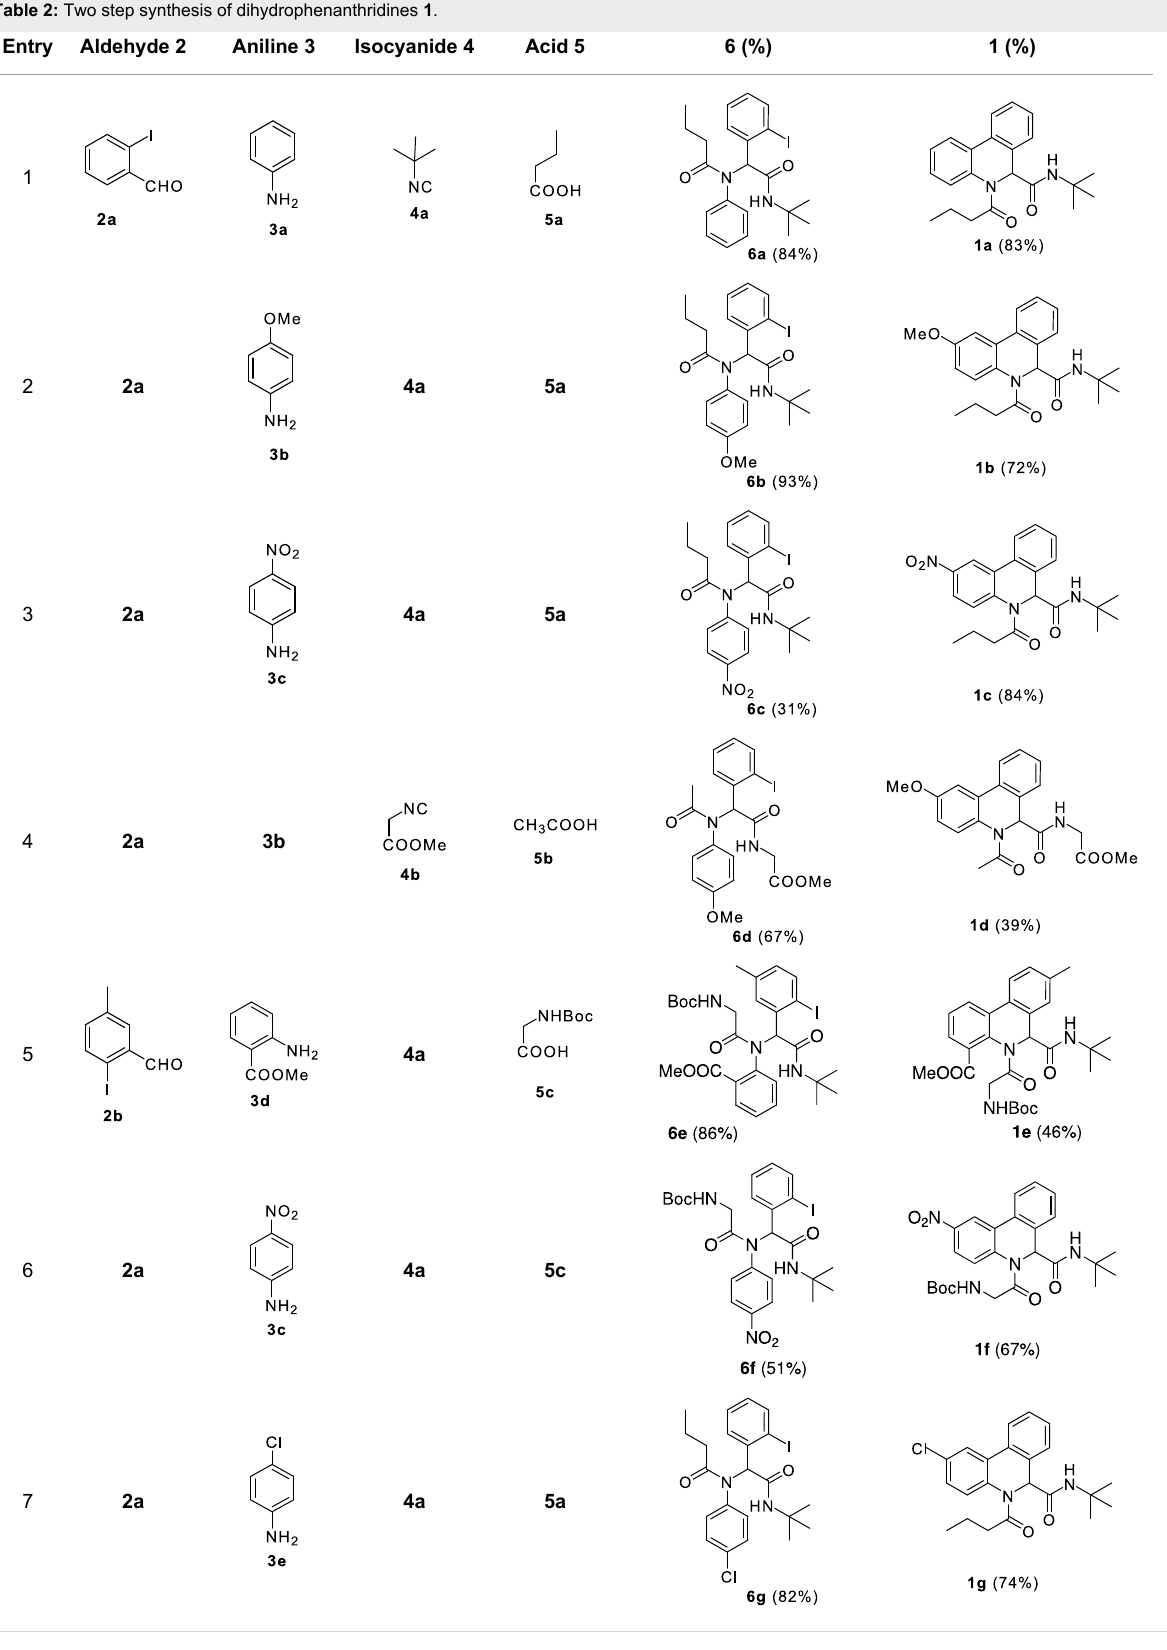
Table 2: Two step synthesis of dihydrophenanthridines 1